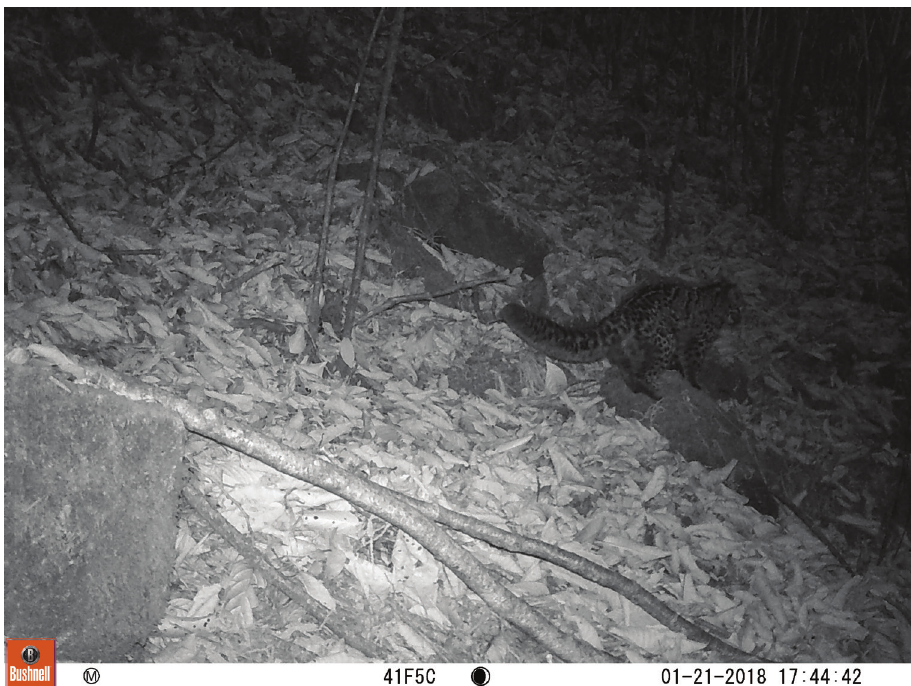
Figure 2. An image of the first marbled cat in Nepal from the camera trap (Sonam Tashi Lama-Lincoln University/Red Panda